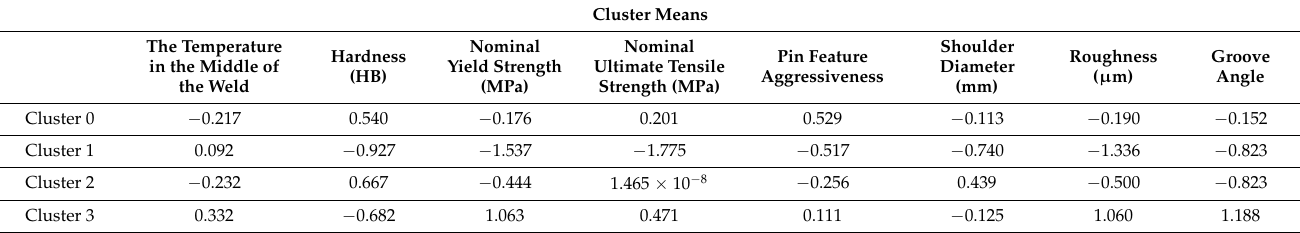
Table 3. The clustering means of the welded joint